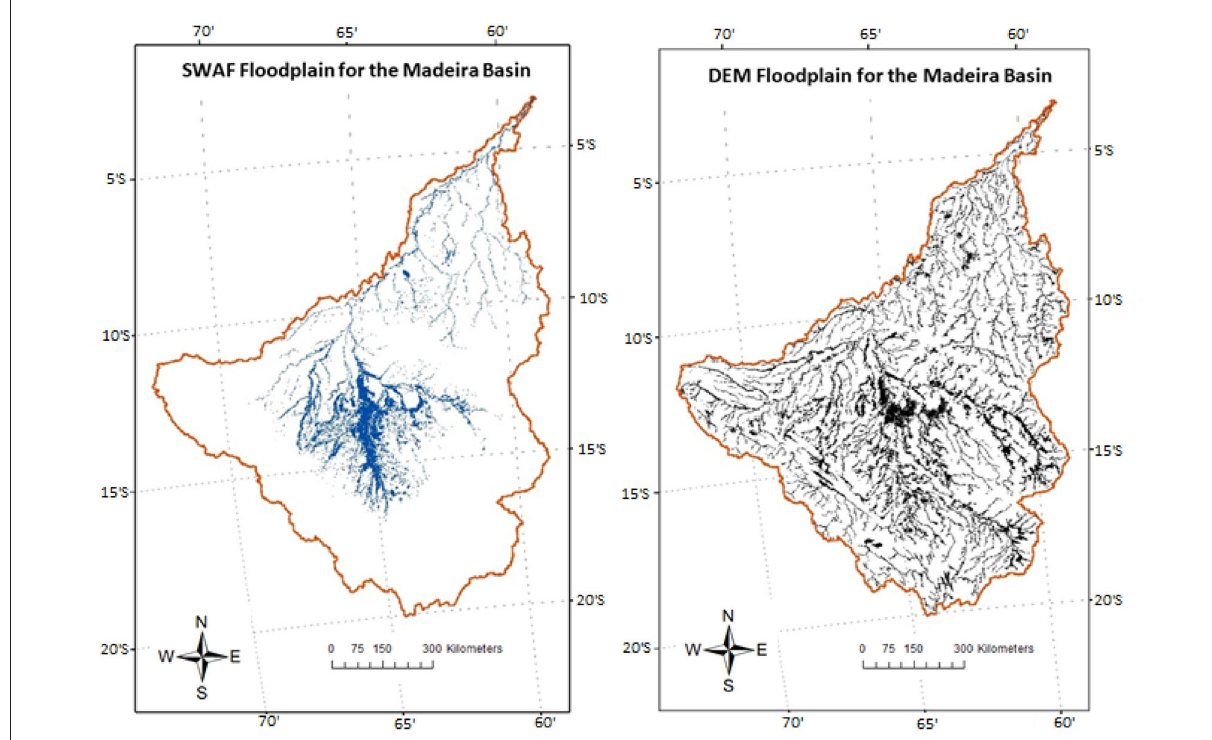
FIGURE3 Spatial representation of the SWAF-HR floodplain (left) and the DEM-based floodplain for the Madeira Basin (right)